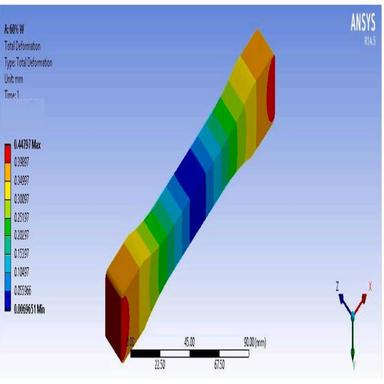
Total deformation of Citrus limetta peel powder composites on the tensile specimen.